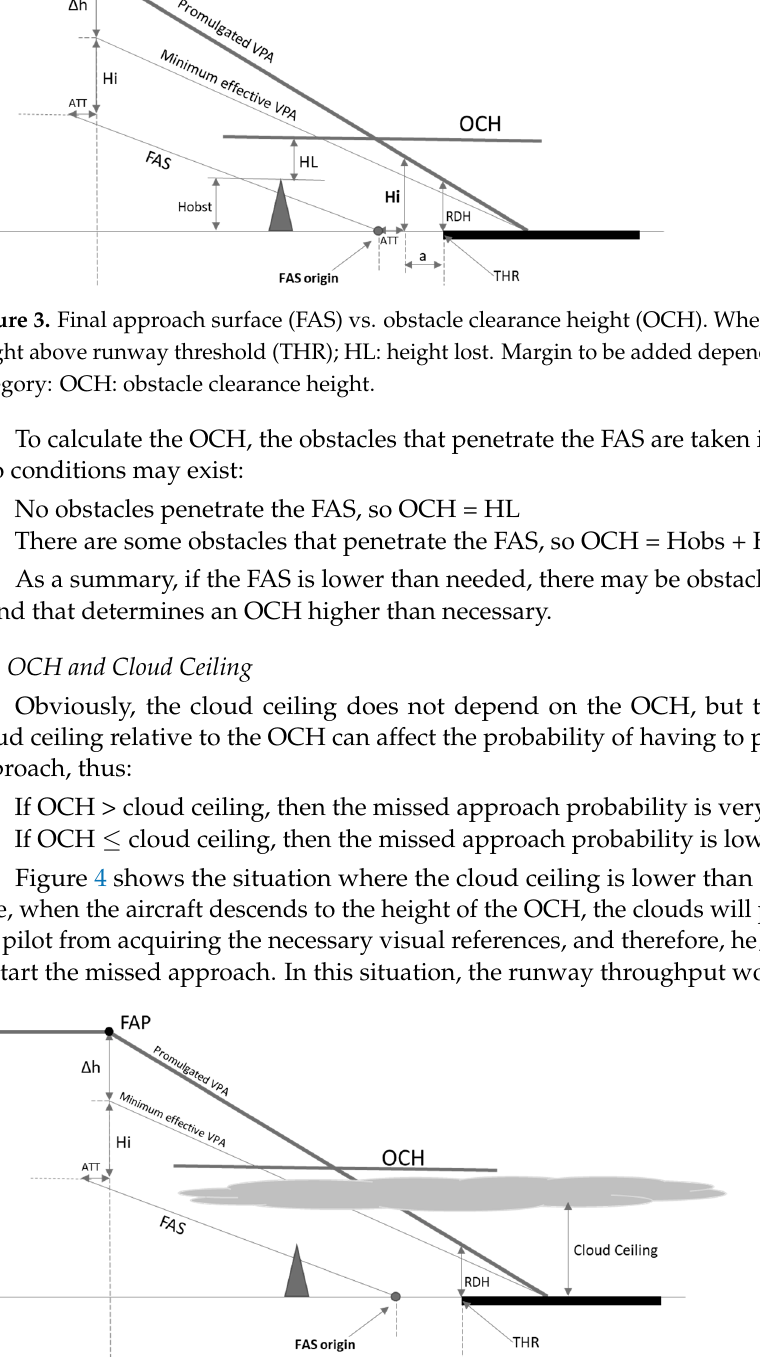
Figure 4. Obstacle clearance height (OCH) and cloud ceiling.